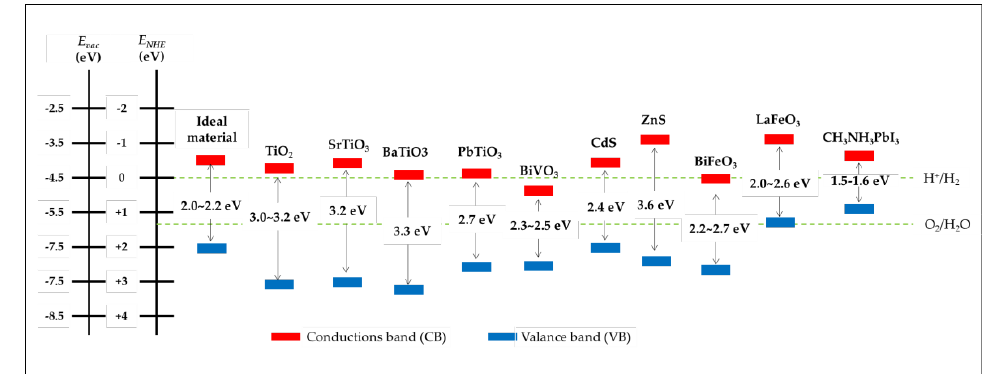
Figure 5. The bandgap of various materials including ferroelectrics and the semiconductor.